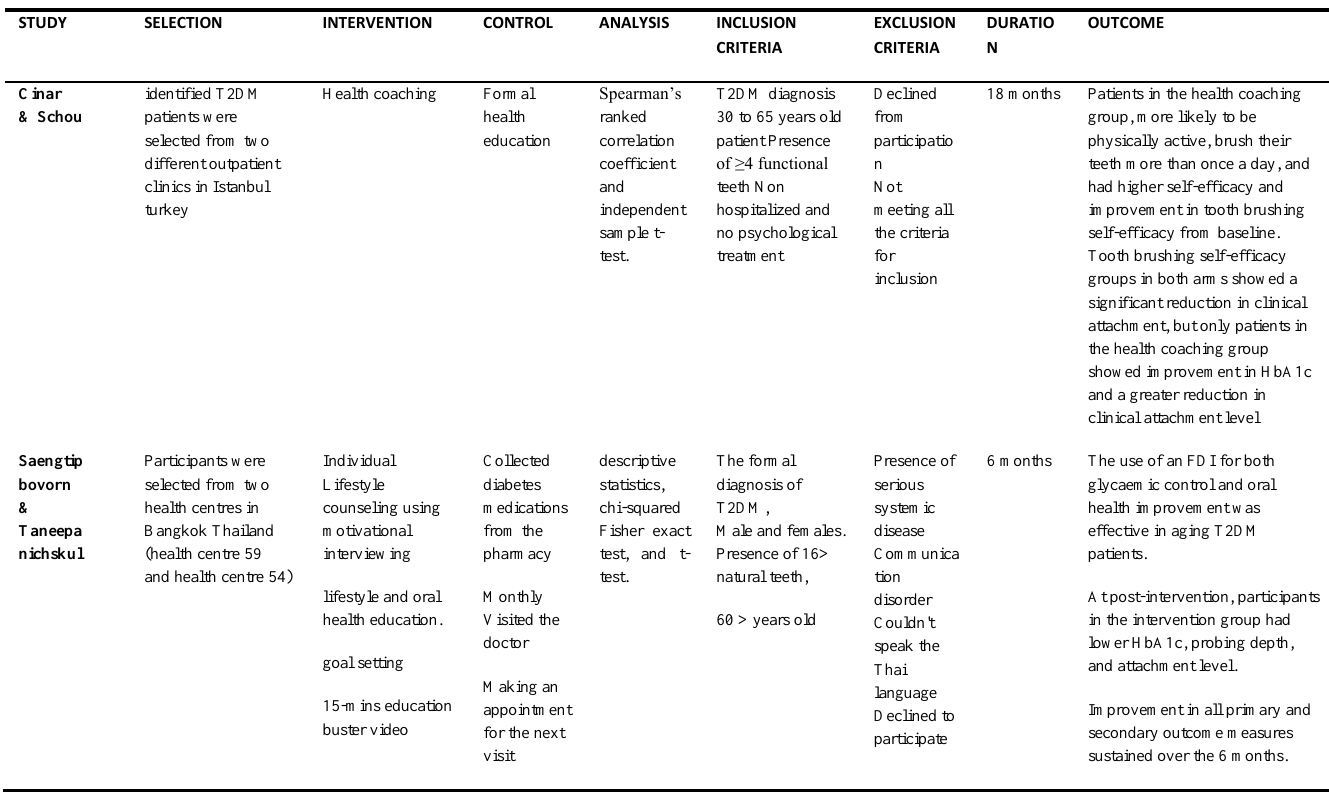
Table 1B: Characteristics of Included Studies